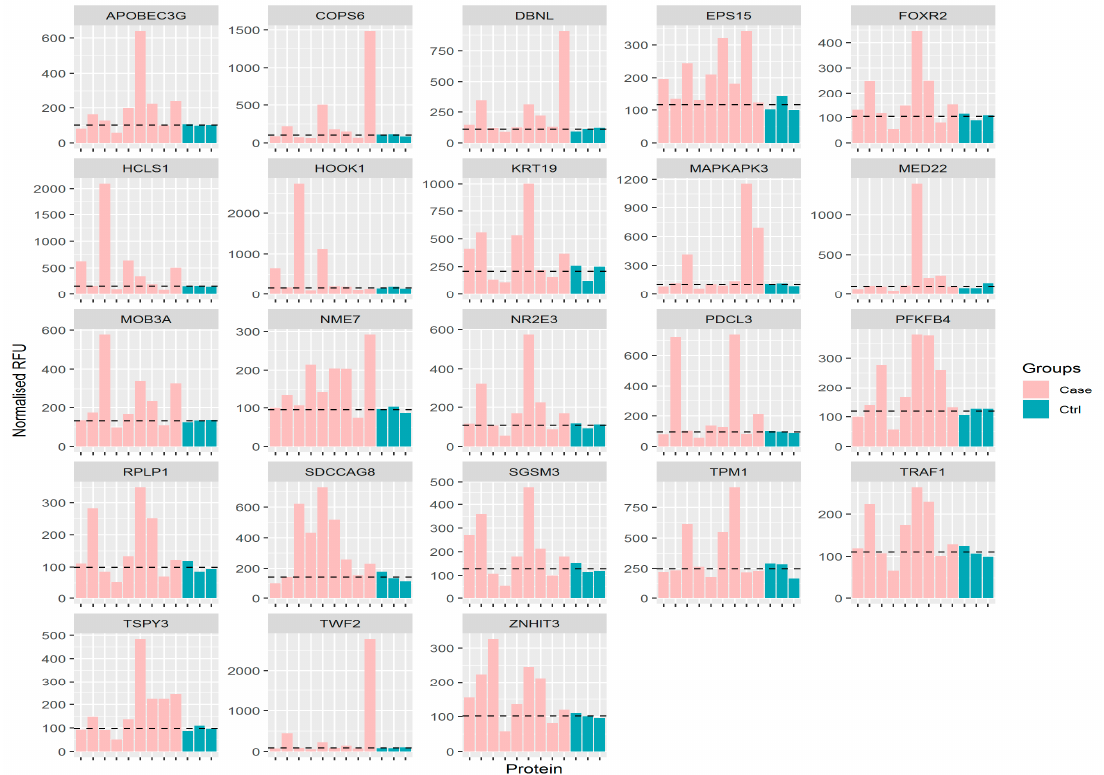
Figure 6. Profile of all 23 biomarkers in all beta-thal major (pink) in relative to healthy control (green). The discontinuous line represents the mean of control sample.